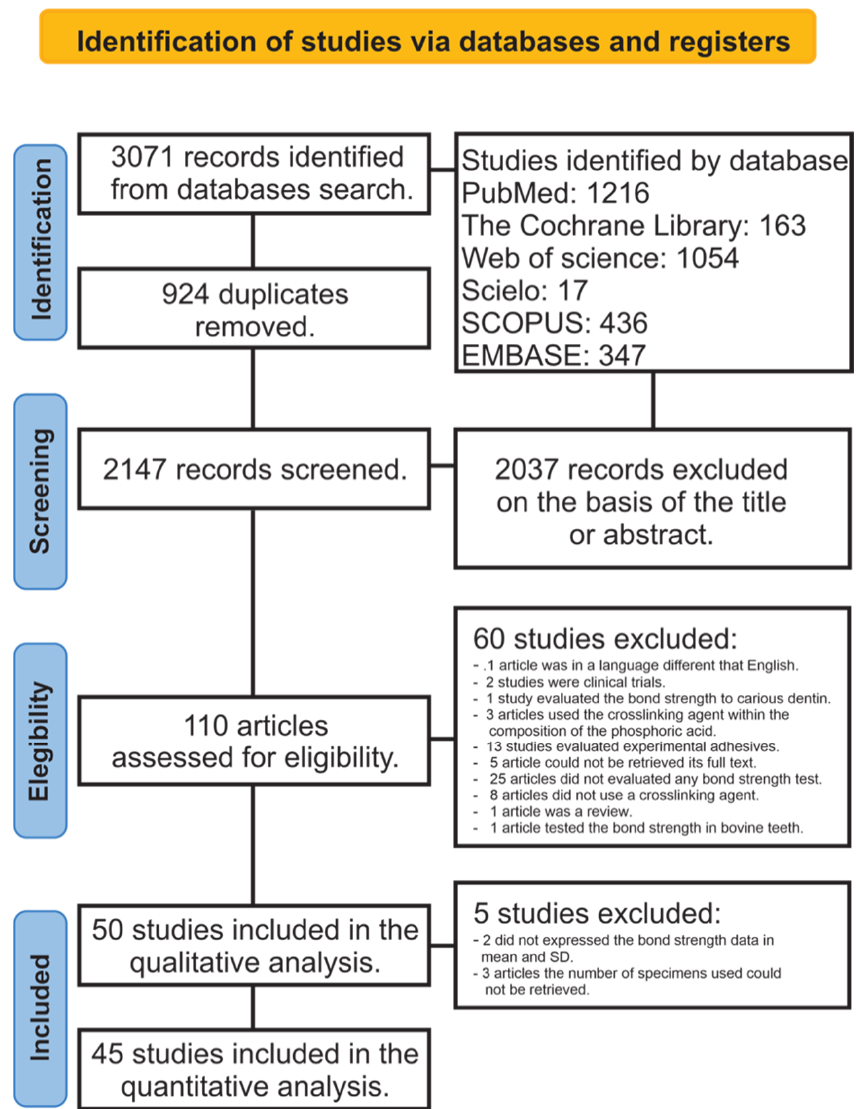
Figure 1. Flowchart according to PRISMA guidelines.